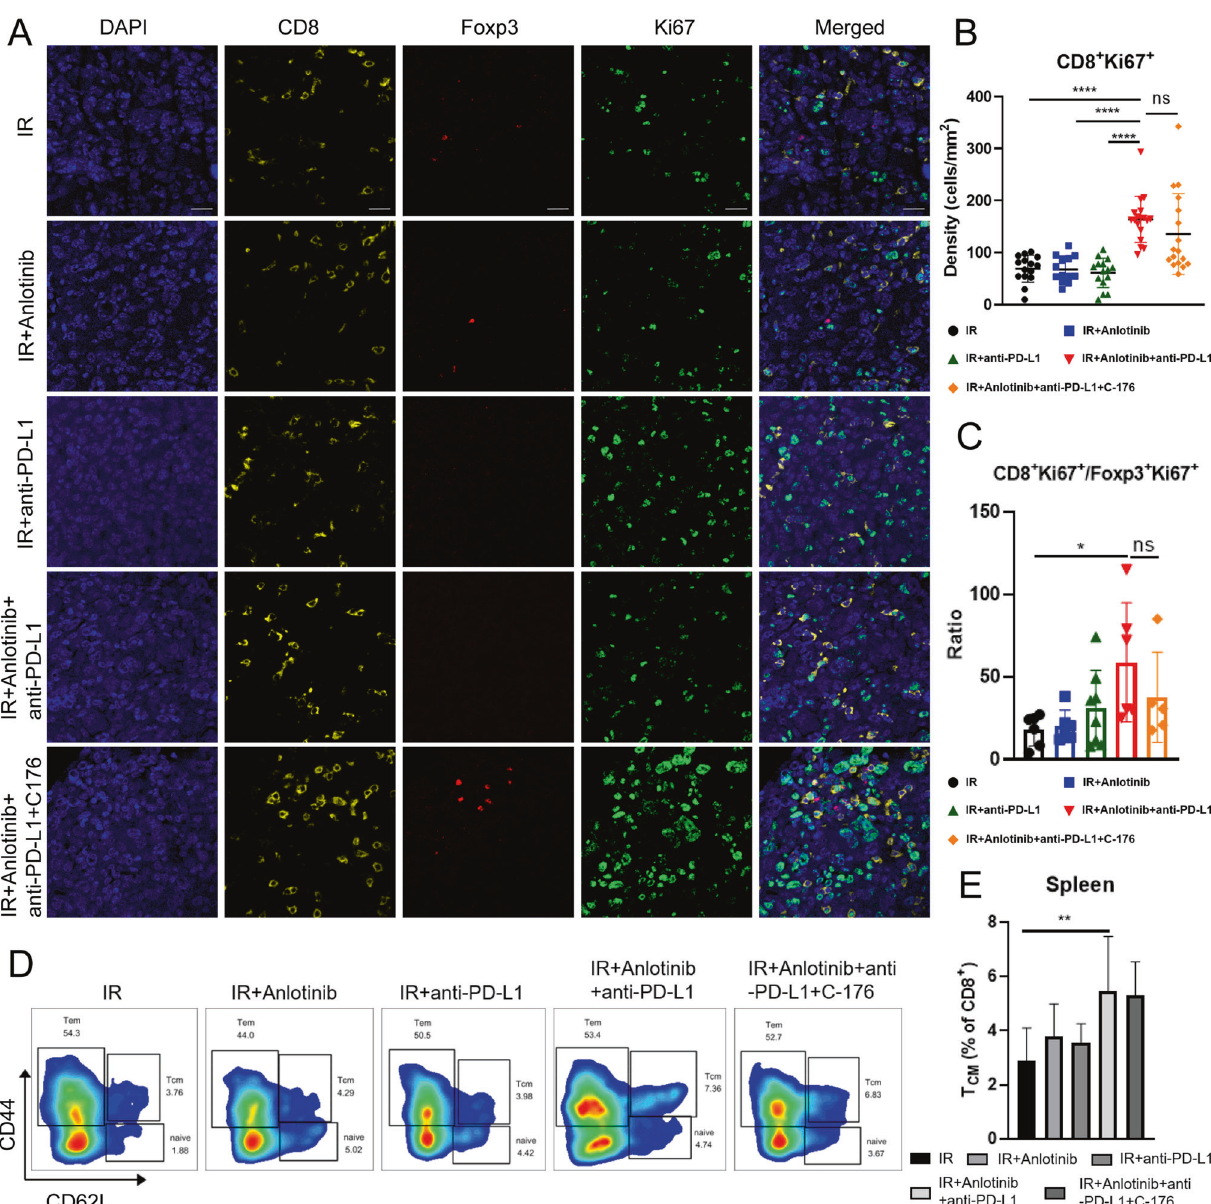
Fig. 6 Triple therapy enhances immune memory activation. A Representative multiplex immuno fl uorescence images of CD8 + T cells (yellow), Foxp3 (red), Ki67 (green) and nuclear staining (DAPI, blue; 40× magni fi cation). Scale bar, 20 μ m. B Triple therapy increased the proliferation of tumor-in fi ltration CD8 + T cells. One-way ANOVA with Tukey ’ s multiple comparison. C Triple therapy increased the ratio of CD8 + Ki67 + /Foxp3 + Ki67 + . One-way ANOVA with Tukey ’ s multiple comparison. D Representative fl ow cytometry staining depicting CD62L and CD44 expression in CD8 + T cells in spleen on day 21. E Percentage of T CM (CD62L + CD44 + ) of CD8 + T cells in spleen on day 21. One-way ANOVA with Tukey ’ s multiple comparison. Data represents the mean ± standard deviation, * p < 0.05, ** p < 0.01, *** p < 0.001, **** p < 0.0001.